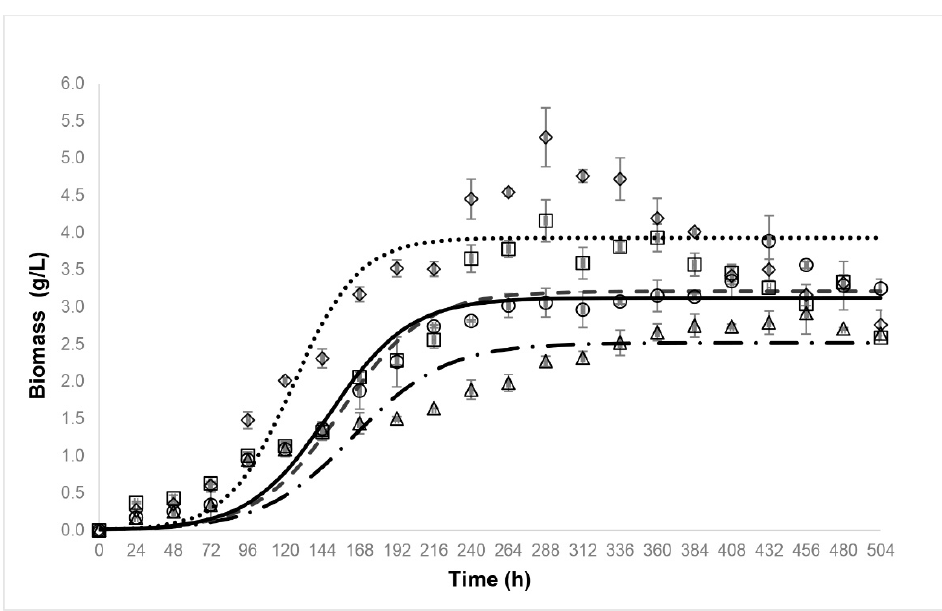
Figure 4. Growth kinetics of Emmia latemarginata. Emmia latemarginata was grown in submerged fermentation at 30 °C for 22 days in a basal medium and in the presence of 500 ppm AYG dye, 10% v/v wheat straw extract or the combination of both, ○ --- Basal medium, Δ - . - . - Basal medium + AGY, ◊ …. Basal medium + wheat straw and □ — Basal medium + wheat straw + AYG. The error bars represent the standard deviation for the three different fermentation runs.